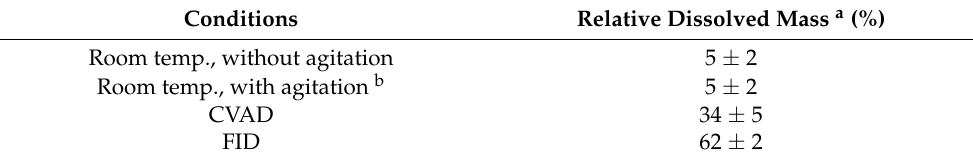
Table 8. Dissolved magnet mass after 15 min of contact time with 3.2 N of H 2 SO 4 ( n = 3).